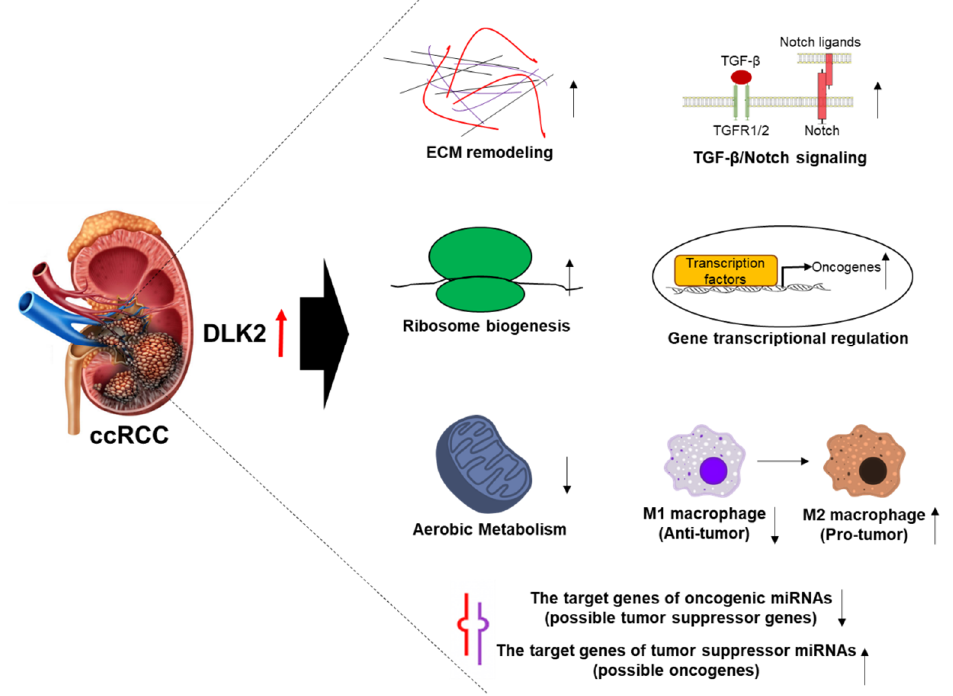
Figure 12. Hypothetical model for the role of DLK2 in ccRCC.